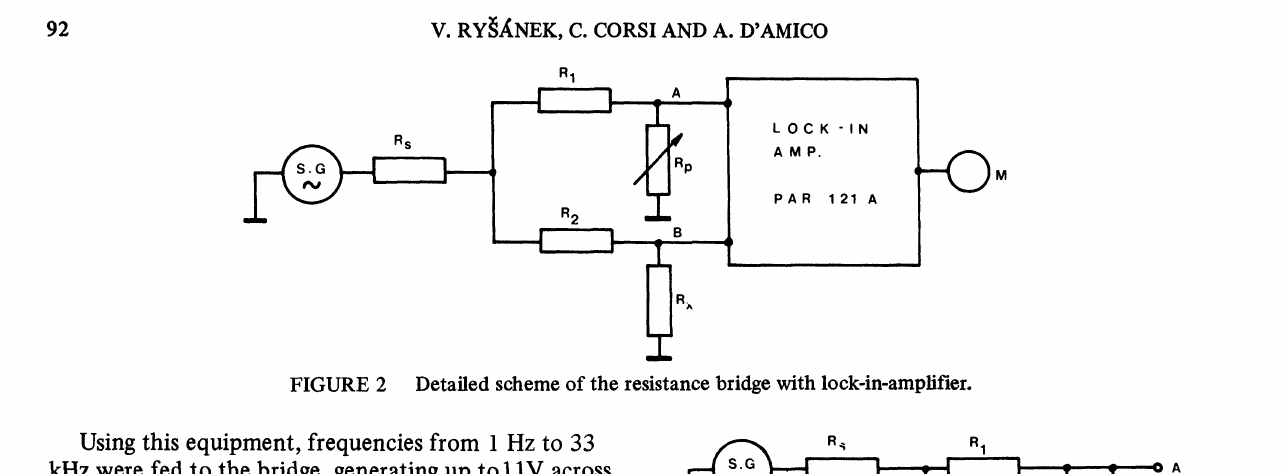
FIGURE 2 Detailed scheme of the resistance bridge with lock-in-amplifier.